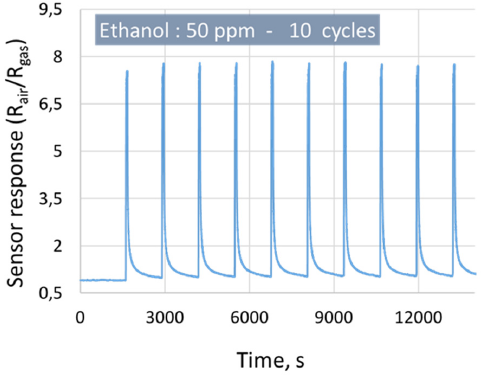
Figure 11 . A comparison between the sensor responses to the presence of dry air at 50% of RH and 70% of RH.